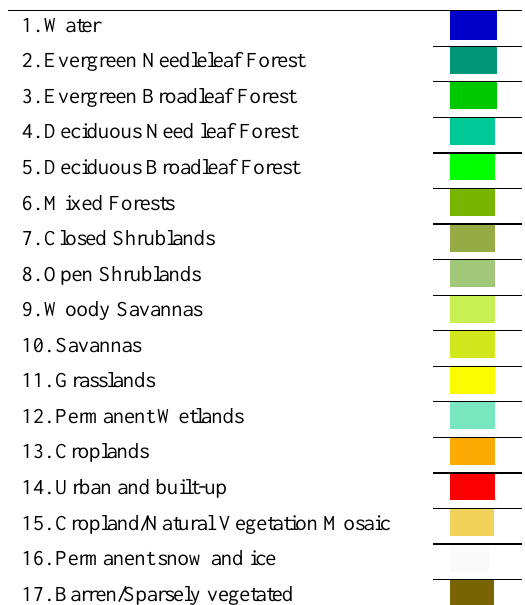
Table 1. Land cover categories(IGBP